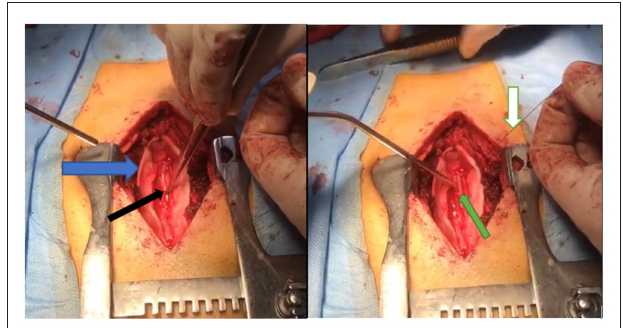
FIGURE 1 | Intraoperative images showing the insertion of the syringosubarachnoid shunt. The dura is opened (blue arrow), the tube is inserted into the resection dead space and into the syrinx (black arrow). The shunt is seen laying in the resection dead space is anchored to the overlying dura using a 6-0 silk suture (white arrow).